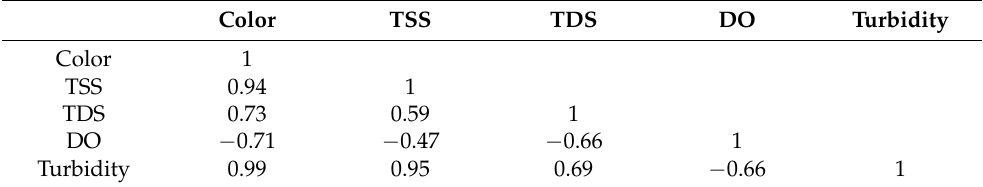
Table 1. Relationship among color, TSS, TDS, DO, and turbidity in the raw wastewater. Color